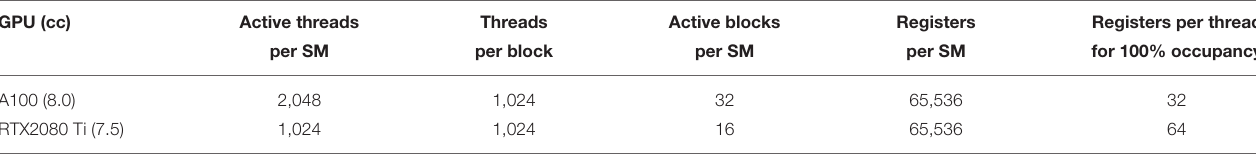
TABLE 1 | Hardware limits relevant to determine theoretical occupancy of GPU